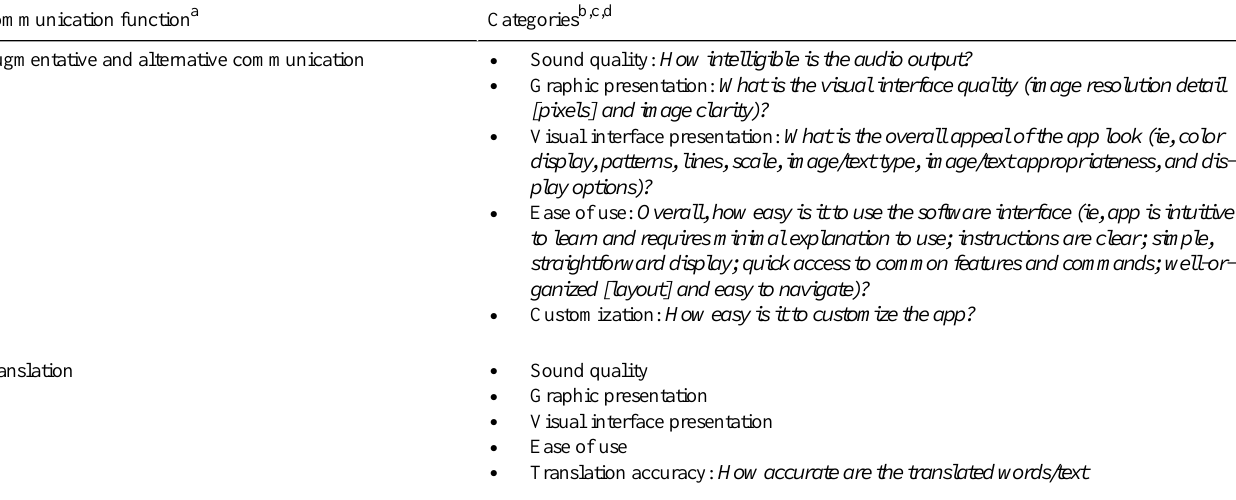
Categories b,c,d Communication function a